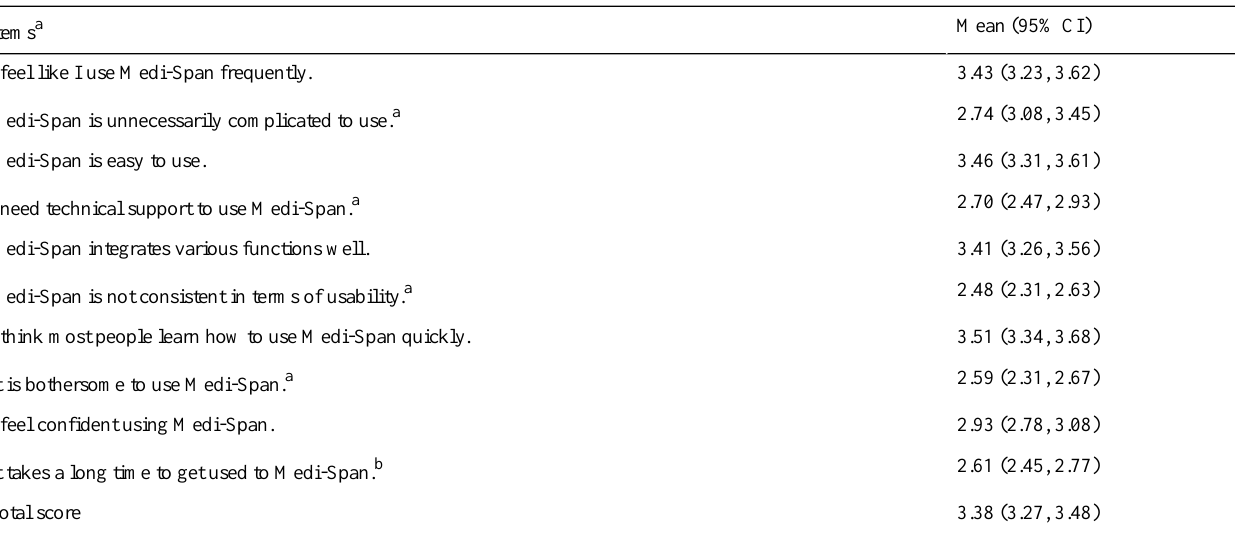
Table 6. Usability test